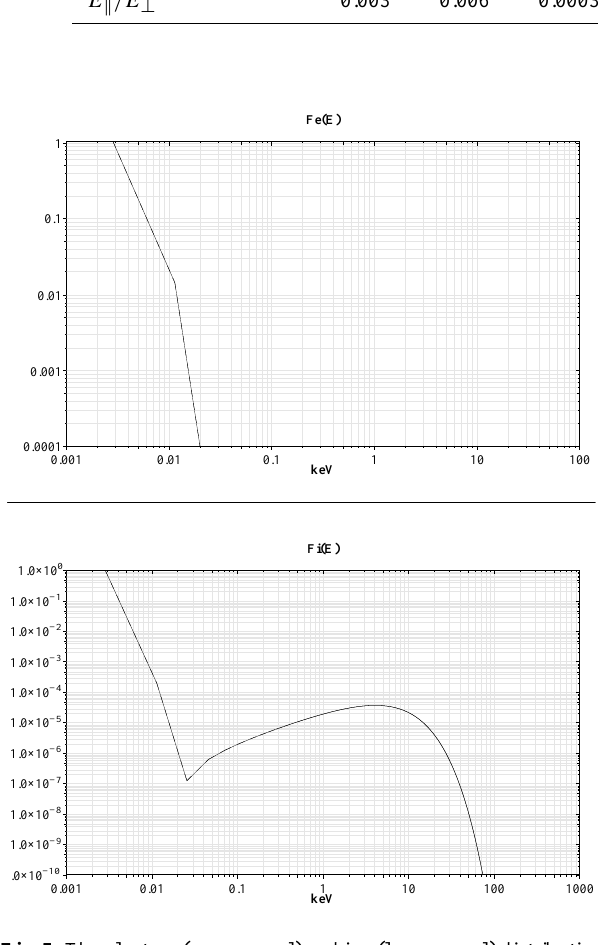
Fig. 5. The electron (upper panel) and ion (lower panel) distribution functions of the plasma model. The vertical axis is in arbitrary units, the maximum being normalised to